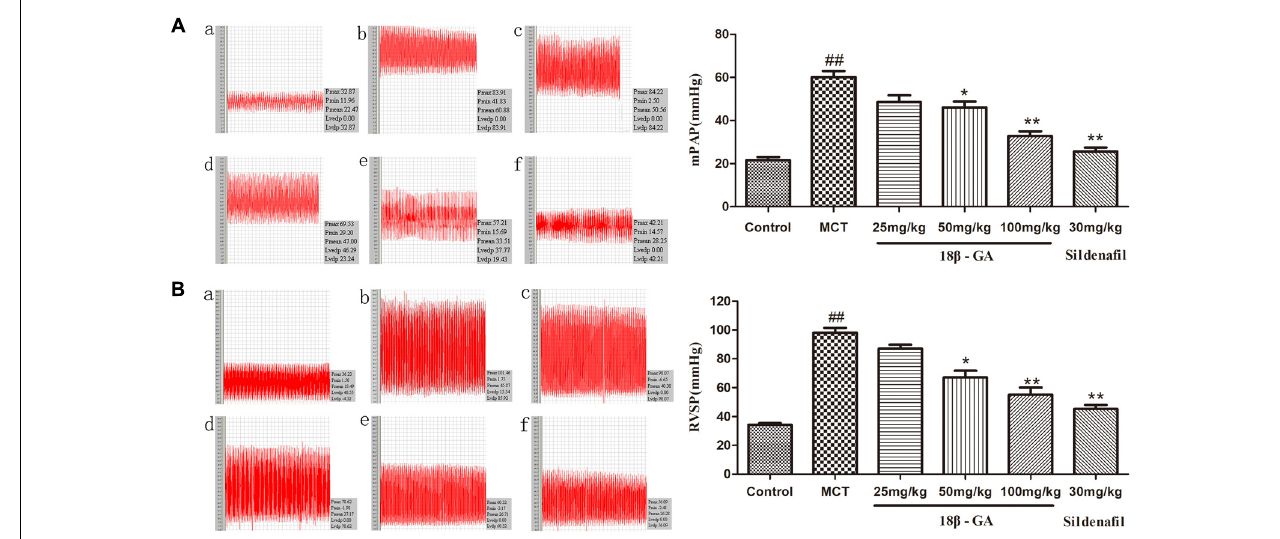
FIGURE 4 | Effect of 18 β -glycyrrhetinic acid treatment on MCT-induced pulmonary arterial hypertension. (A) Effect of 18 β -glycyrrhetinic acid on mean pulmonary arterial pressure (mPAP). (B) Effect of 18 β -glycyrrhetinic acid on right ventricular systolic pressure (RVSP). (a) Control group; (b) MCT group; (c) 18 β -GA 25 mg/kg group; (d) 18 β -GA 50 mg/kg group; (e) 18 β -GA 100 mg/kg group; (f) Sildenafil 30 mg/kg group. Data are expressed as mean ± SEM ( n = 10). ## p < 0.01 vs. control group, ∗ p < 0.05, ∗∗ p < 0.01 vs. MCT group. MCT, monocrotaline; 18 β -GA, 18 β -glycyrrhetinic acid; mPAP, mean pulmonary arterial pressure; RVSP, right ventricular systolic pressure.